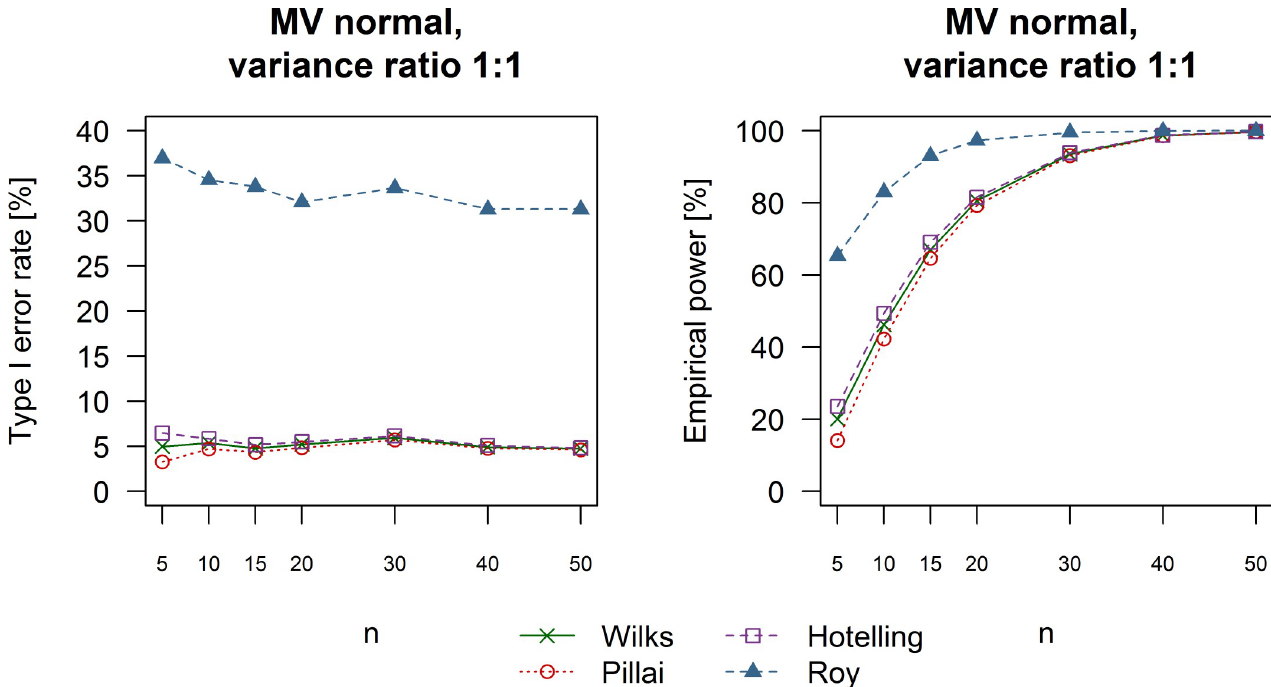
Fig 1. Performance of different multivariate statistics. Example plots show empirical type I error and power of the MANOVA test using four common multivariate test statistics. Type I error rate is shown for the simulation scenario with no treatment effects, equal variance in all groups and data drawn from a multivariate normal distribution. An example of power analysis is shown for a simulation with large treatment effects (Cohen’s d equal to 0.8), equal variance in all groups and data sampled from a multivariate normal distribution. Hotelling: Lawley-Hotelling trace; Pillai: Pillai’s trace; Roy: Roy’s largest characteristic root; Wilks: Wilks’